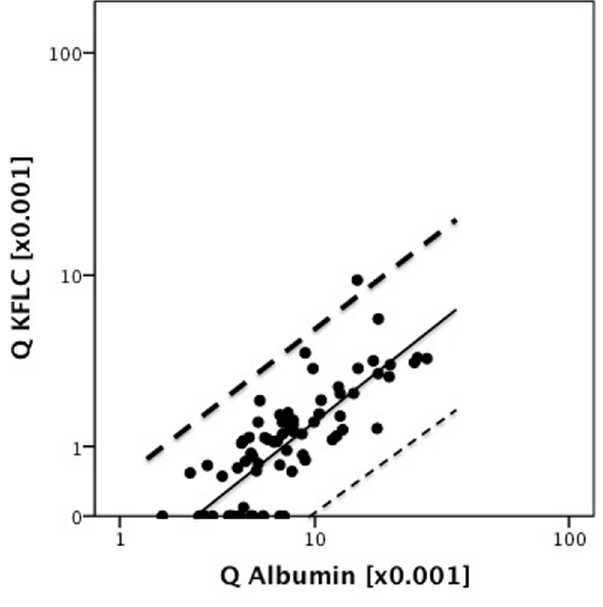
Figure 2. Cerebrospinal fluid – serum ratio of kappa free light chain (Q KFLC) is plotted against CSF-serum ratio of albumin. Dashed lines indicate the 99% confidence interval of the linear regression line (straight line). The upper 99% confidence interval (dark dashed line) indicate the approximately upper reference value of Q KFLC based on a control group of 77 non-inflammatory neurologic diseases and a range of Q Albumin from 1.9 to 28.2.